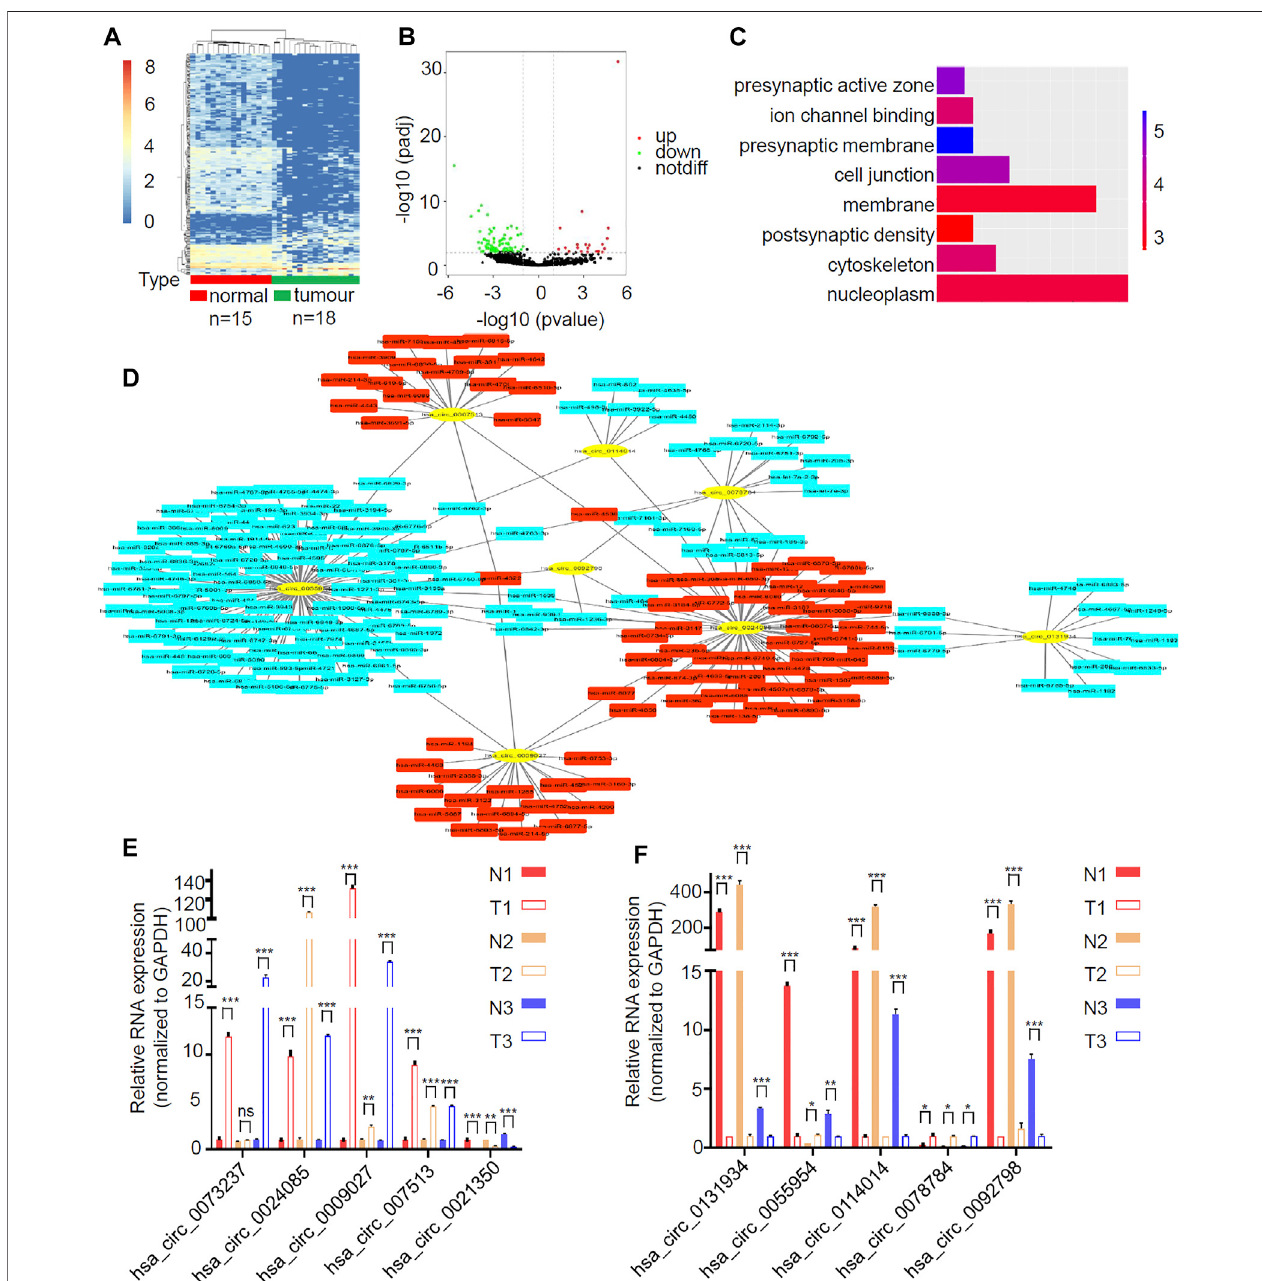
FIGURE 1 | circLRRC7 was the most signi fi cantly differentially expressed circRNA in GBM relative to normal brain. (A) Clustered heatmap showed tissue-speci fi c circRNAs between 15 normal brain tissues and 18 gliomas. The color scale indicates the log2 value of the ratio of the differential gene expression (red represents up- regulation; blue represents down-regulation). (B) Volcano plot of differentially expressed circRNAs. The red dots and green dots represent upregulated circRNAs and downregulatedcircRNAswithsigni fi cance(|logFC| > 1,padj < 0.05). (C) GOanalysisofdifferentiallyexpressedcircRNAs. (D) circRNA-miRNAnetworkofthetop10 differentially expressed circRNAs. (E,F) The relative expression of the top 10 differentially expressed circRNAs in 3 pair of GBM samples and adjacent surgical margin samples with qRT-PCR. (ns, p > 0.05; * p < 0.05; ** p < 0.01; *** p < 0.001).